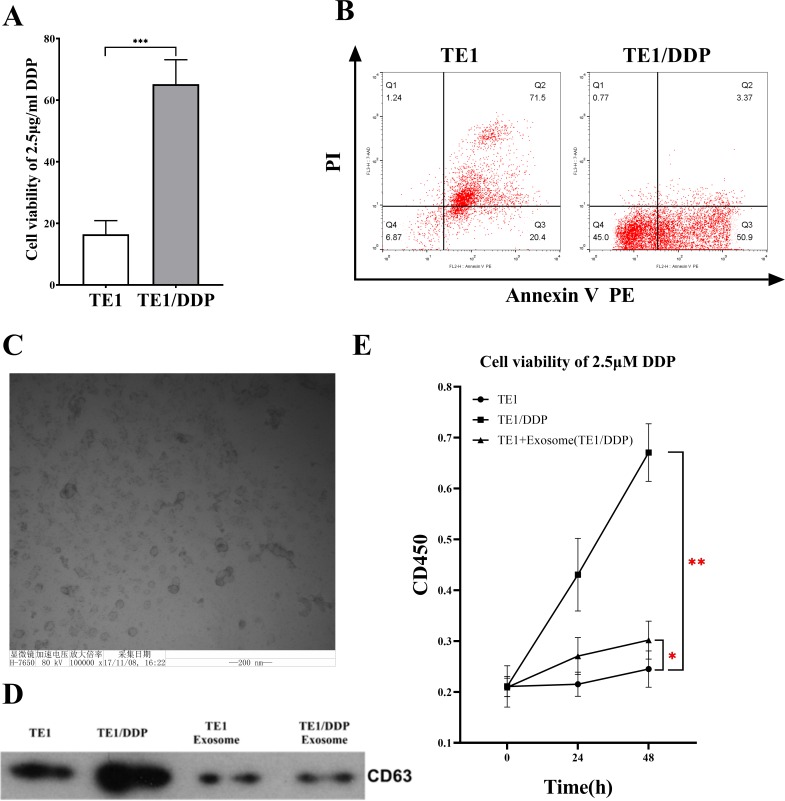
Identification of drug-resistant cell lines and exosomes.A: Detection of cell viability of original cell line (TE-1) and drug-resistant cell line (TE1/DDP) under 2.5 μM DDP conditions. B: Apoptosis detection in original cell line (TE-1) and drug-resistant cell line (TE1/DDP) under 2.5 μM DDP. C: Scanning electron microscopy to identify exosomes. D: Western blot analysis of good exosome membrane protein marker CD63. E: CCK-8 detects cell viability showing that drug-resistant exosomes (TE1/DDP/exo) promote DDP resistance in TE1 cells.